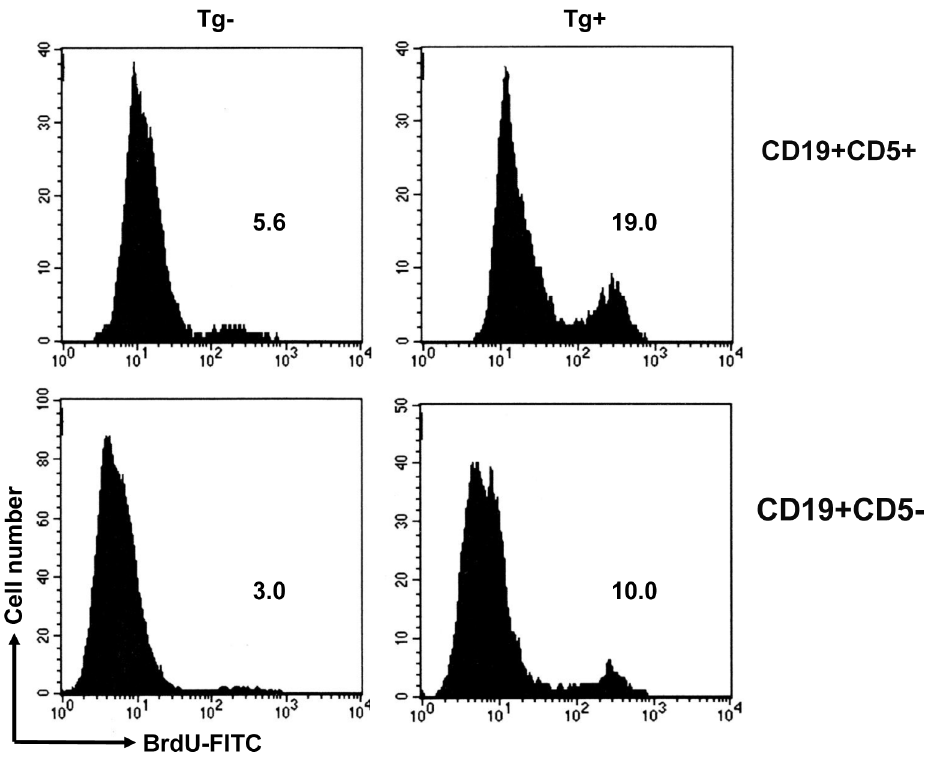
Figure 4. BrdU incorporation assay. BrdU was i. p. injected with C. albicans inoculation to TgV H 3B4 mice and littermate, and injected for the second time 12 h later. PEC cells were eluted at 36 h after inoculation and BrdU labeling was performed using a BrdU Labeling kit and analyzed by FCM. Data are representative of four independent experiments.